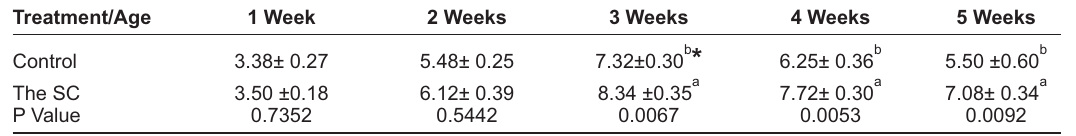
Table-5: Effect of The SC on haemagglutination inhibition (HI) antibody titer against Newcastle disease vaccine in broiler